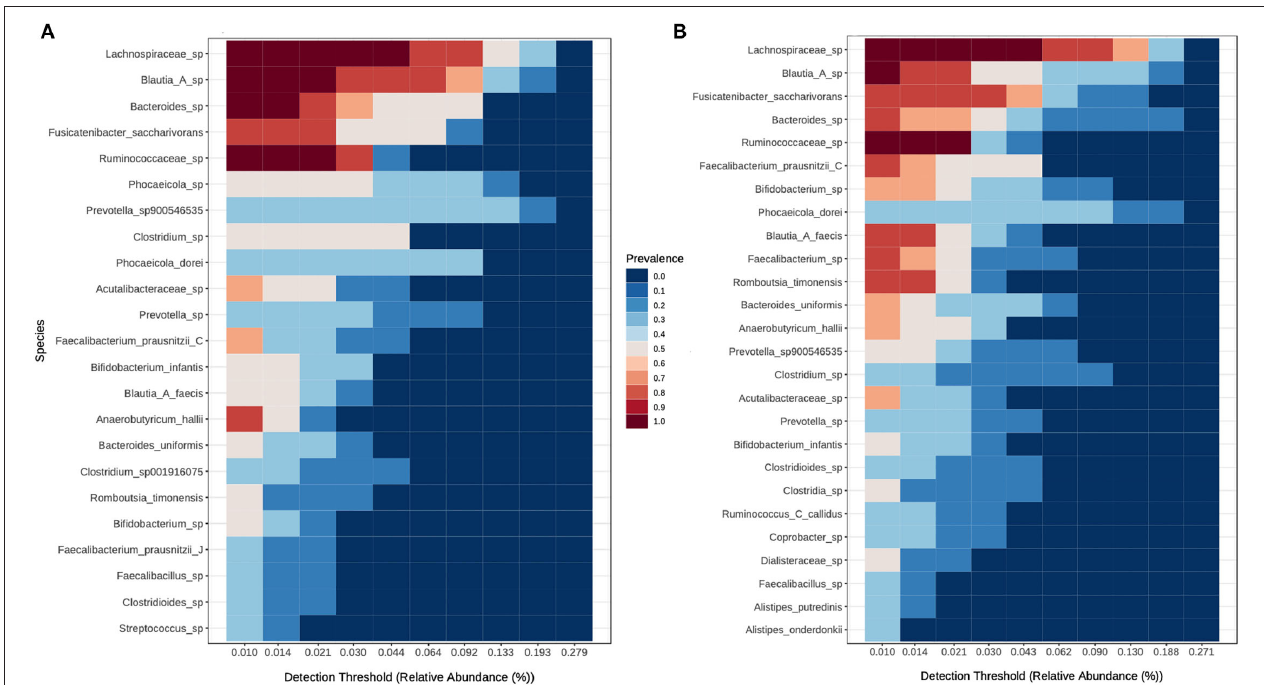
FIGURE 5 | Average total and individual SCFA concentrations across Bristol stool form groups. The Y-axis is plotted on a log 2 scale.